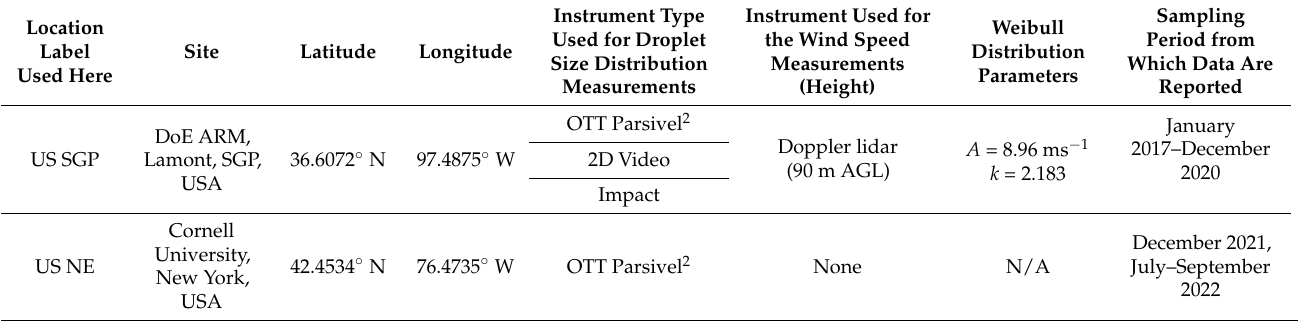
Table 1. Summary of the locations from which data are reported